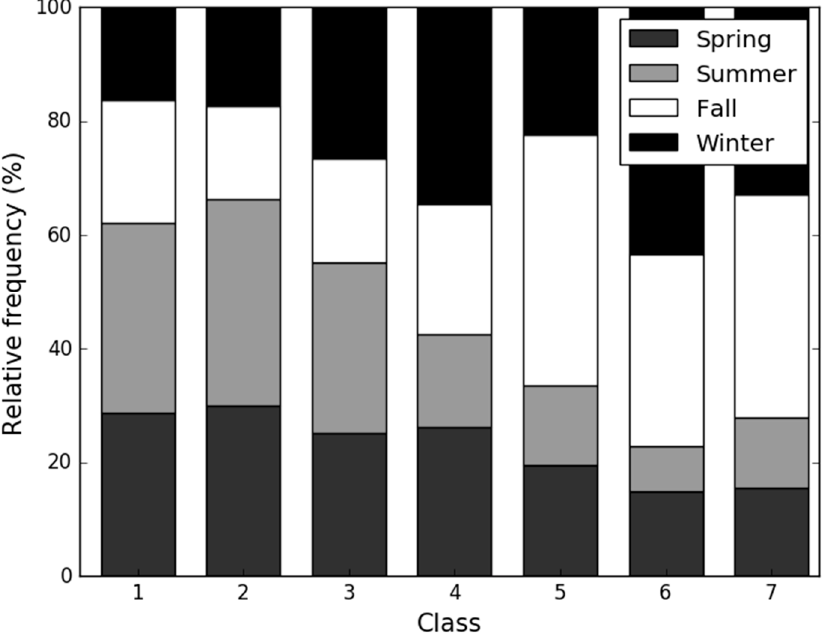
Figure 8. Relative frequencies (%) of the trajectory occurrences as a function of the season for the seven classes resulting from the cluster